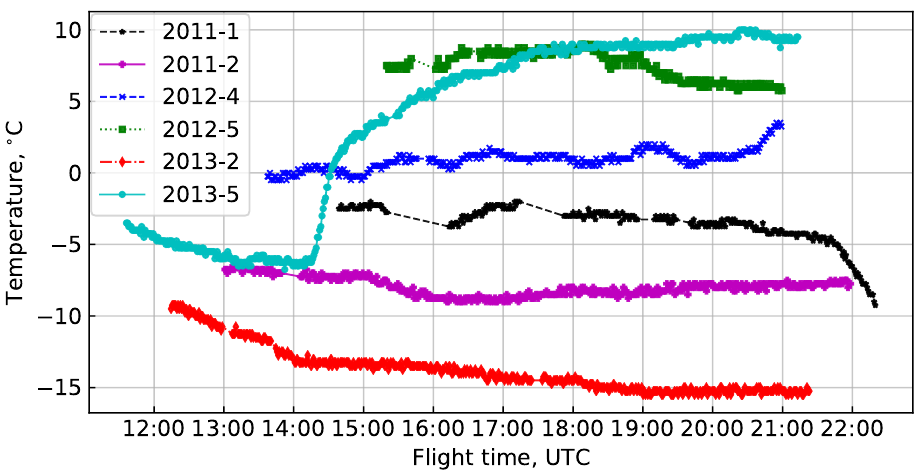
Figure 7. Altitude of the SPHERE-2 detector carried by the BAPA tethered balloon according to the GPS module data during 2011–2013 flights.